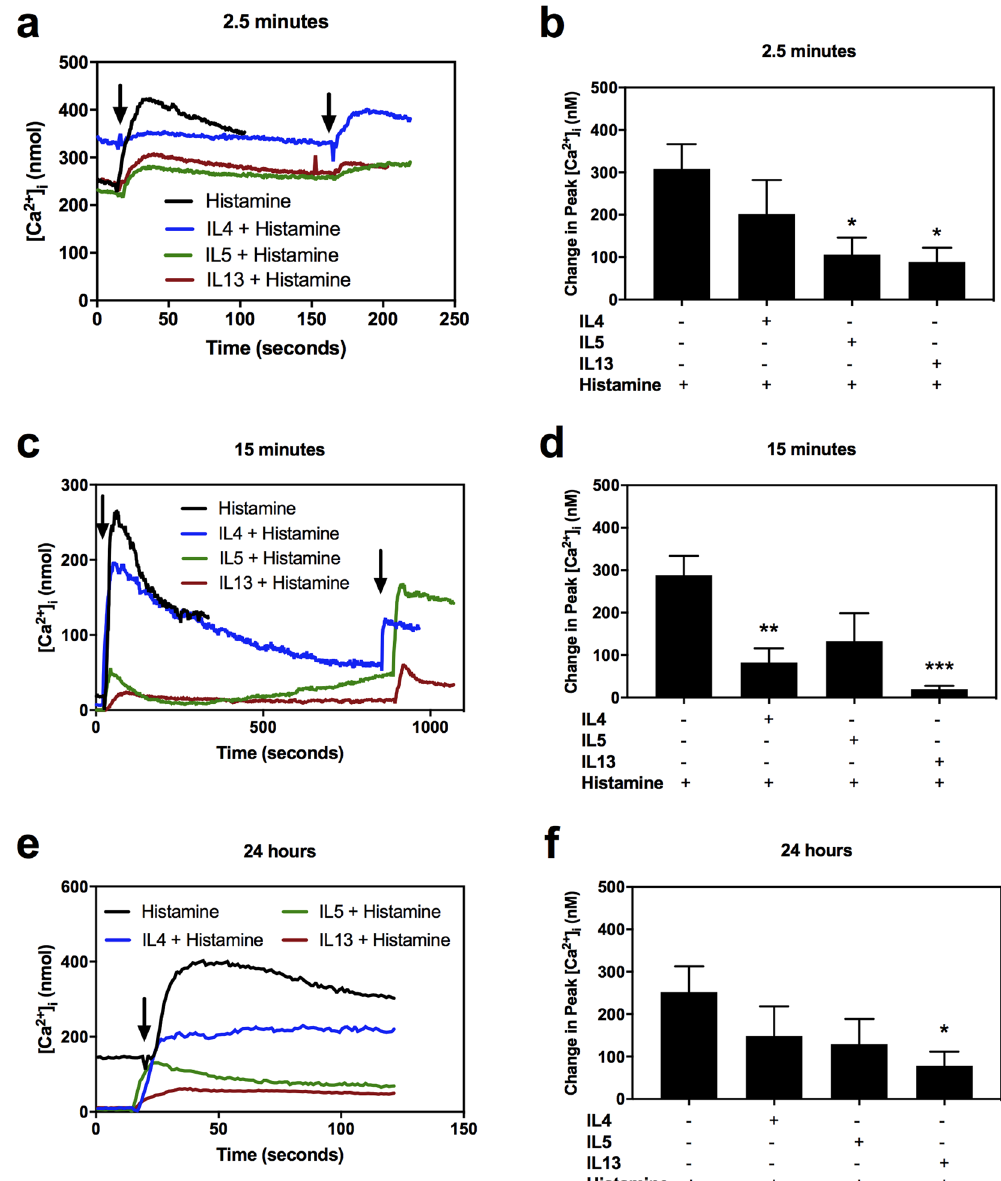
Figure 4. Effect of IL incubation time on histamine stimulated increase in intracellular [Ca 2 + ] ([Ca 2 + ] i ) in rat conjunctival goblet cells. Mean [Ca 2 + ] i response to histamine over time ( a , c , e ) or peak [Ca 2 + ] i over basal ( b , d , f ) after treatment with cytokines at 10 ng/ml each (first arrow) for 2.5 min ( a , b ), 15 min ( c , d ), or 24 h ( e , f ) before the addition of 10 − 5 M histamine (second arrow). At least three independent experiments were performed for each condition. * indicates statistical significance compared to histamine alone. * p ≤ 0.05; ** p ≤ 0.01; *** p ≤